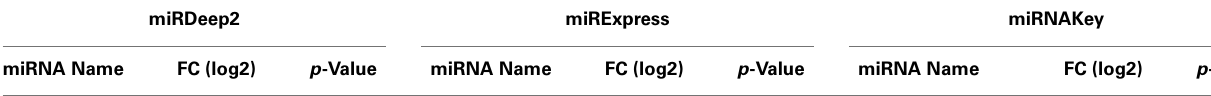
Table 5 | Differentially expressed miRNAs in plasma detected by DESeq for Sham-Surgery vs. nerve crush.